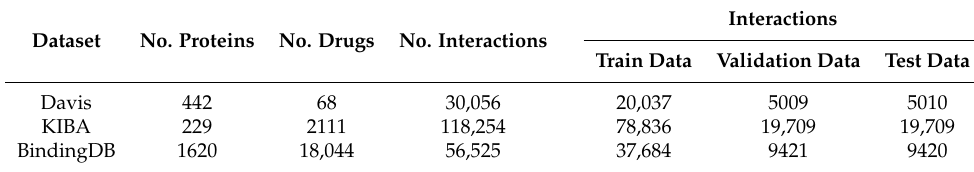
Table 1. The detailed statistics of Davis, KIBA, and BindingDB